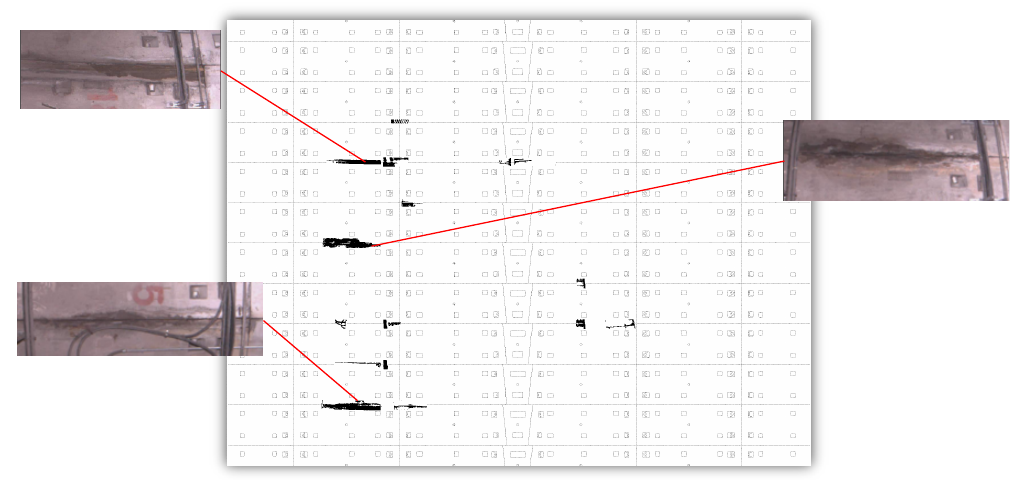
Figure 12. Identification and validation of real leakages in the metro tunnel.